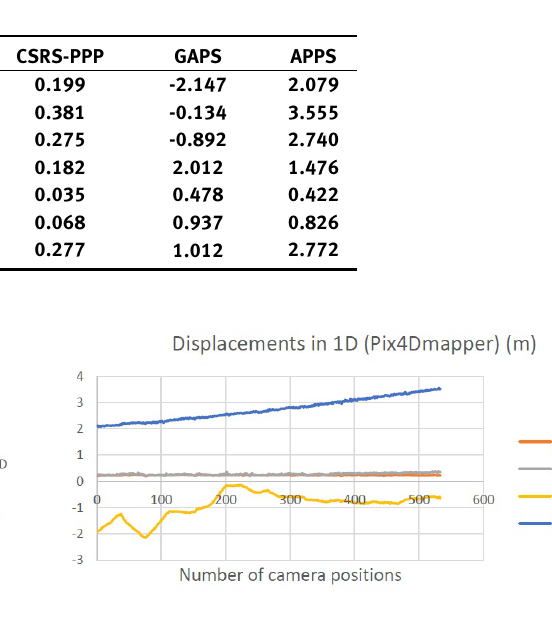
Table 8. Results for 1D displacements (Pix4Dmapper) (m).